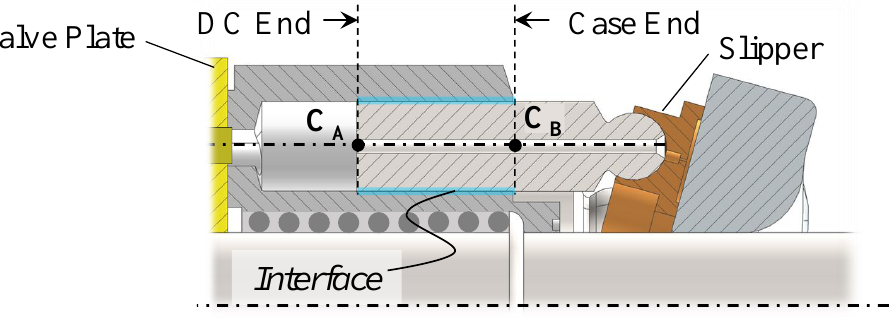
Figure 6. Control points C A and C B .